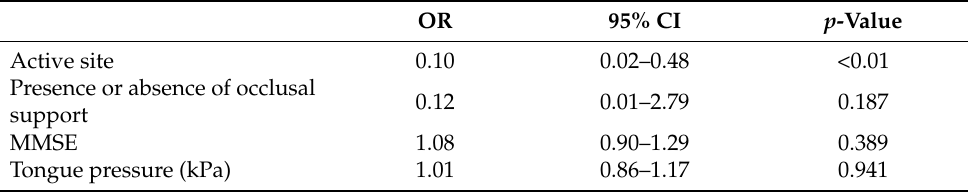
Table 5. Logistic regression analysis of the crushability of